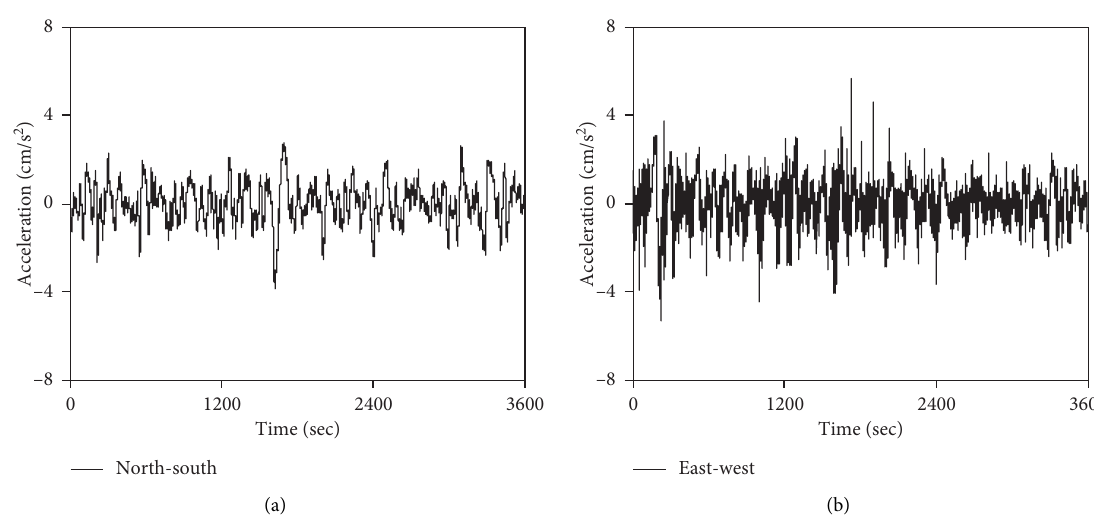
Figure 3: Measured time history accelerations. (a) North-south direction. (b) East-west